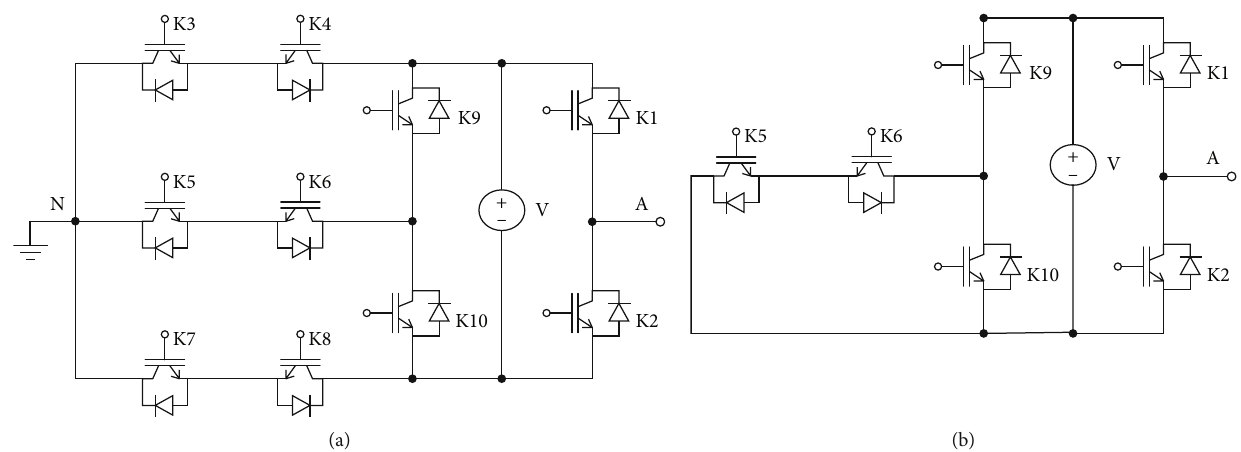
Figure 3: Variants of the three-level inverter (3 L – SMC H-bridge): (a) with three stacked cells and (b) with one stacked cell.